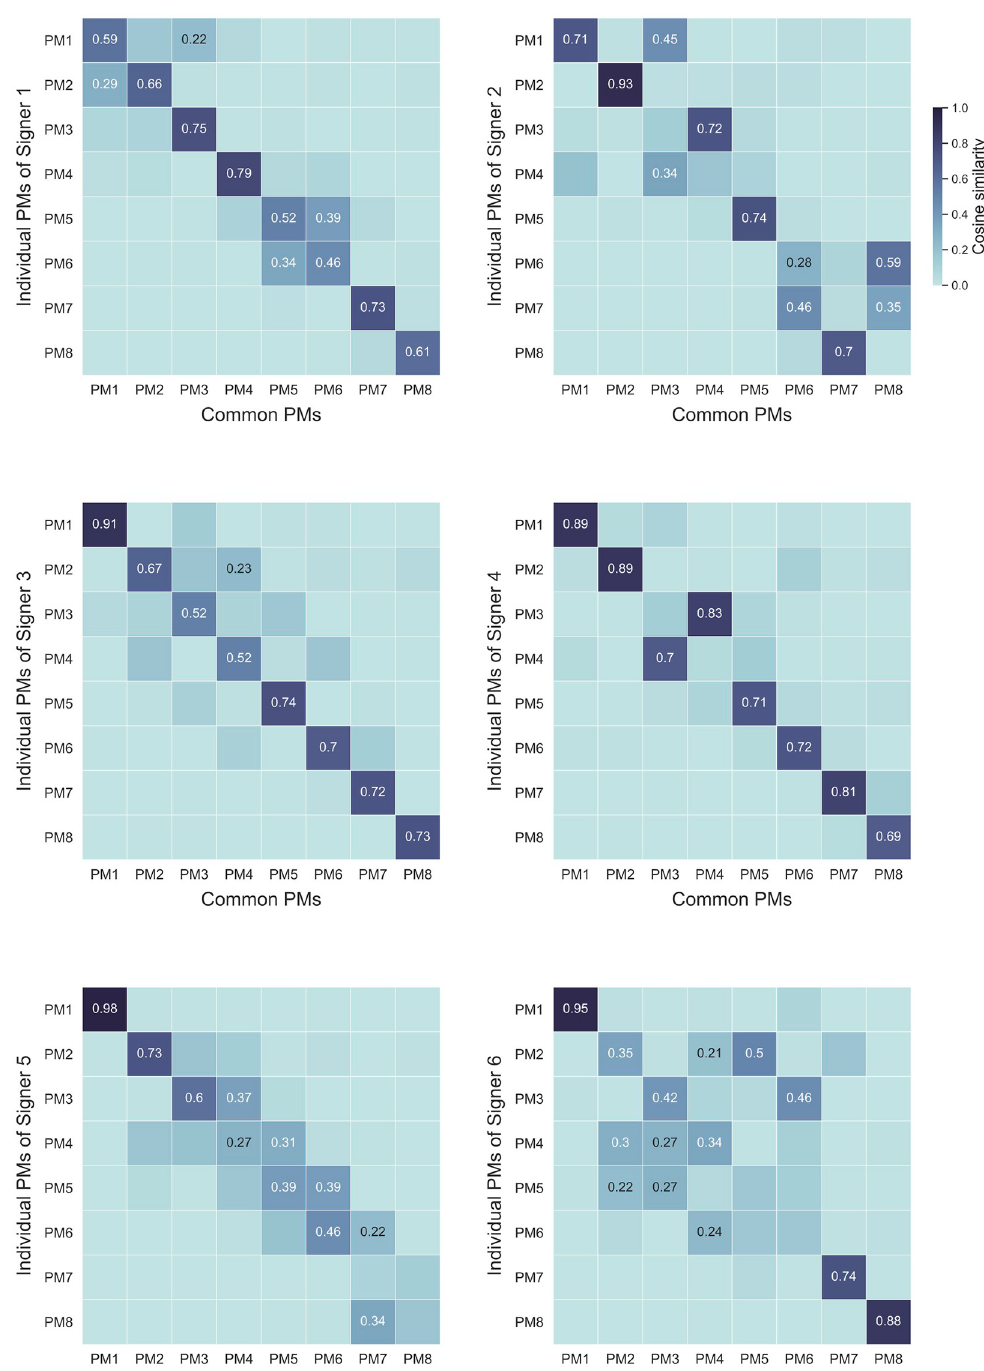
Fig 5. Cosine similarity between individual and common PMs. The similarity measures are specified when sim > 0.2, for sake of visibility.